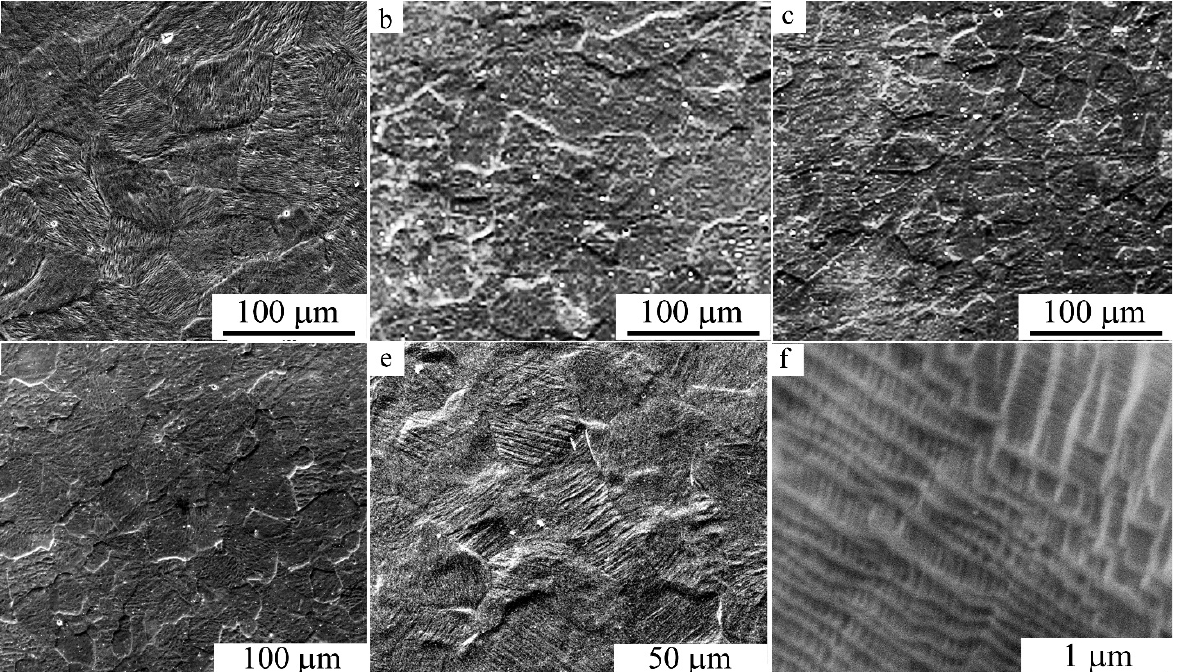
Figure 2. Images typical of ( a , d ) tweed TEM contrast and ( b,c,d,f ) diffuse scattering in SAED pat- terns (( b )—z.a. [100], ( c )—z.a. [111], ( e )—z.a. [110], and ( f )—z.a. [210]) of ( a – c ) Ti 49.4 Ni 50.6 and ( d – f ) Ti 49 Ni 51 quenched alloys). Cooling of quenched alloys below the critical temperature M s leads to the phase TMT transformation B 2 → B 19’ (see Figure 3a). According to the results of XRD analysis, the parameters of the unit cell of the B 2 austenite lattice of alloys vary from 0.3015 to 0.3010 nm with an increase in the nickel content from 50 to 51 wt.%. The parameters of the unit